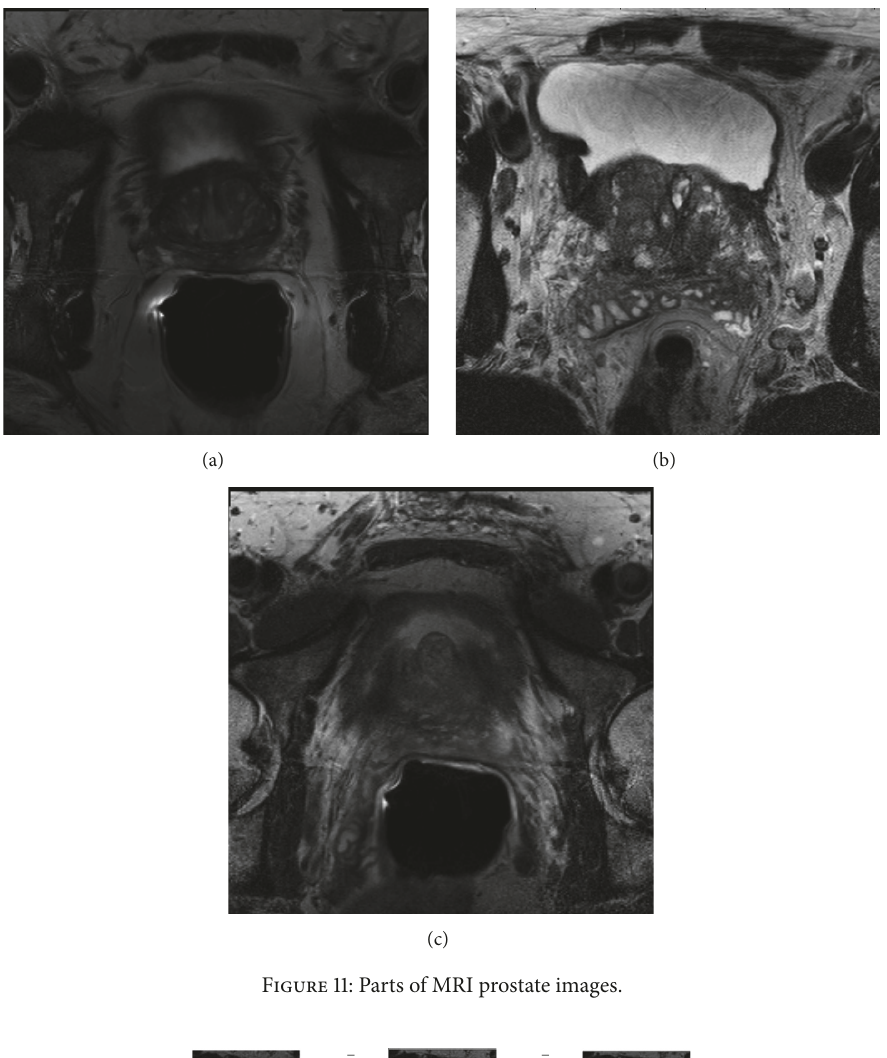
Figure 11: Parts of MRI prostate images.